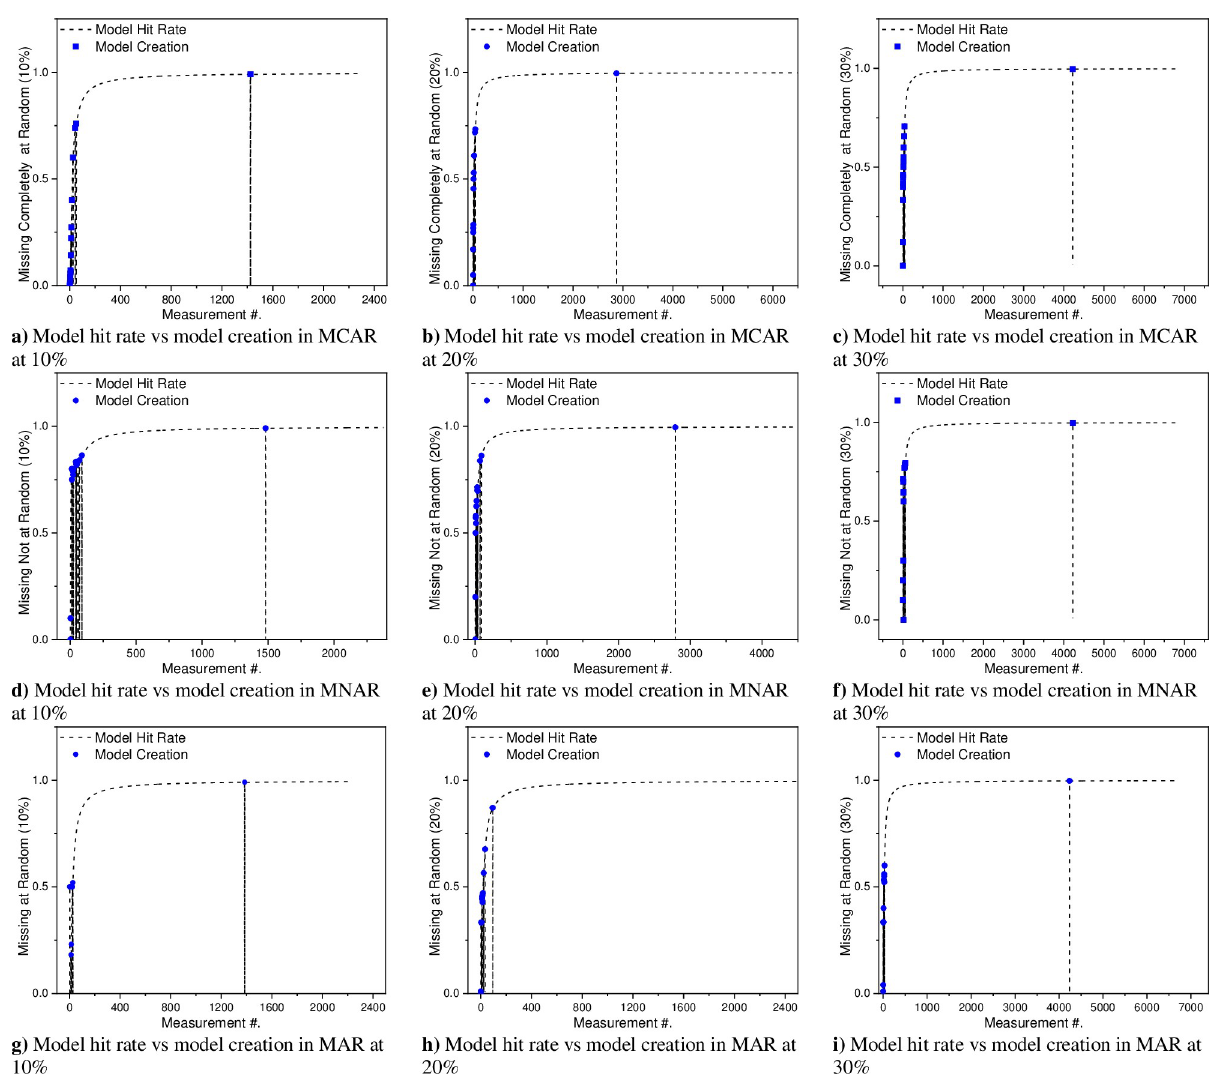
Fig 7. Previously fitted model reusability in subsequent scans with different missingness percentages ranging from 10 to 30 percent, for data missing, with data: a/b/c) completely at random, d/e/f) not at random, and g/h/i) at random. simulated at different missing percentages ranging from 10 to 30 percent in terms of missing completely at random (MCAR), missing not at random (MNAR) and missing at random (MAR) scenarios. In this way, artificially missing value patterns have been introduced in differ- ent features. On imputing the same incomplete data, the proposed methodology outperforms than other frequently used methods such as mean, median, mode, predictive mean matching, and hot-deck imputation. Different statistical parameters, viz. RMSE, RMSLE, MAPE, and MSE, have been calculated and indicates that the proposed methodology-based results got very less error values when compared to other imputation methods at different missing scenarios of MCAR, MNAR, and MAR with the percentages of 10, 20, and 30 percent. The findings of the study show that the efficiency of the proposed methodology lies in the selection of the best pre- dictor variable for different missingness patterns and the utilization of previously fitted mod- els. The runtime decision of choosing the best and available predictor variables for different